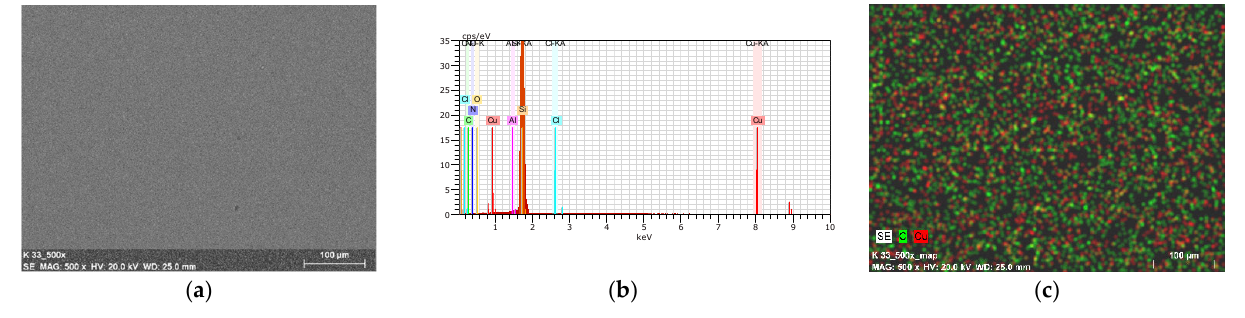
Figure 15. SEM of K1 /Si thermal deposition. ( a ) K1 /Si; ( b ) EDS; and ( c ) mapping of K1 /Si. Magn 500×.